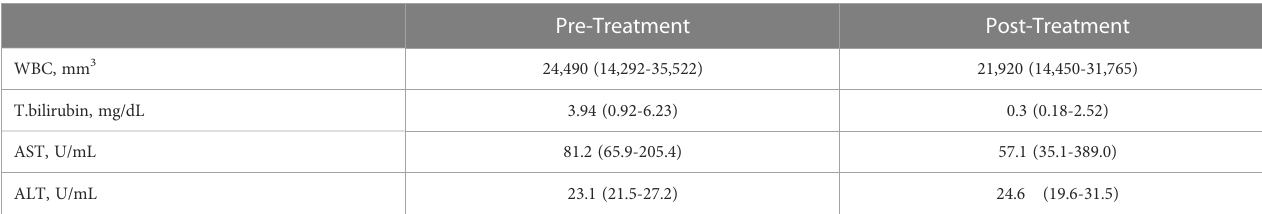
TABLE 2 Changes in laboratory values of the novel stent group